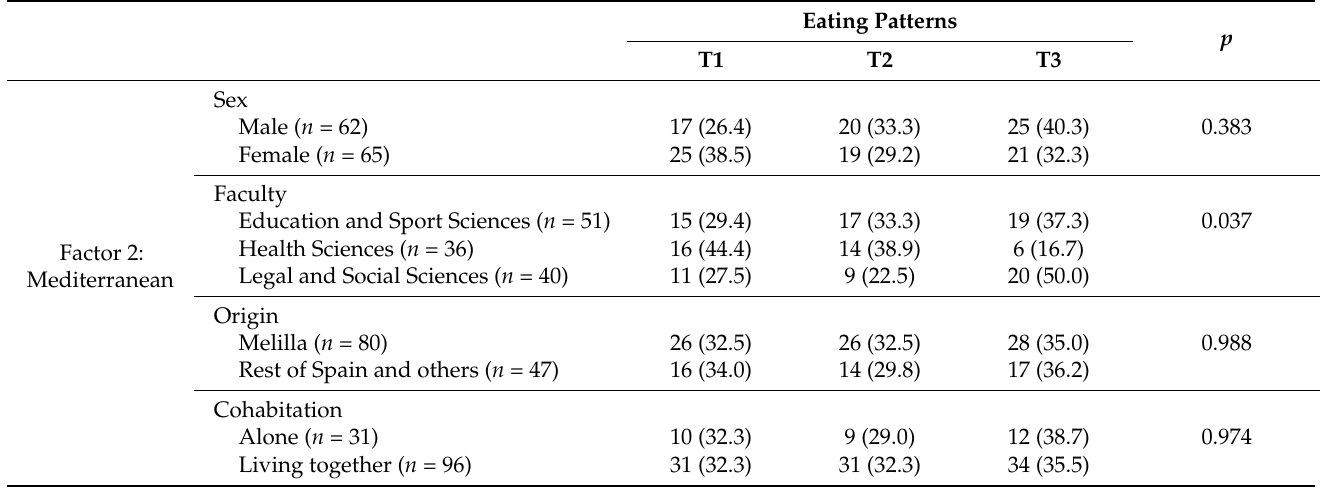
Table 5. Distribution of university professors according to their adherence to the Mediterranean eating pattern (by tertiles), sex, centre, origin, marital status, professional stability, nutritional status, and physical activity.